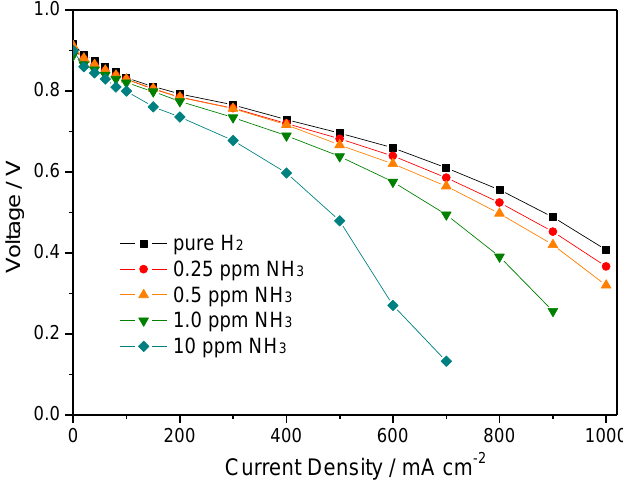
Figure 7. Effects of NH 3 in H 2 on polarization.